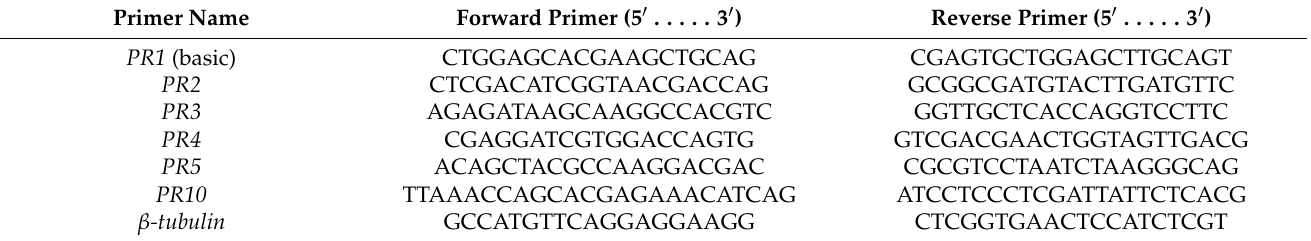
Table 1. The nucleotide sequences of primers utilized in this investigation.